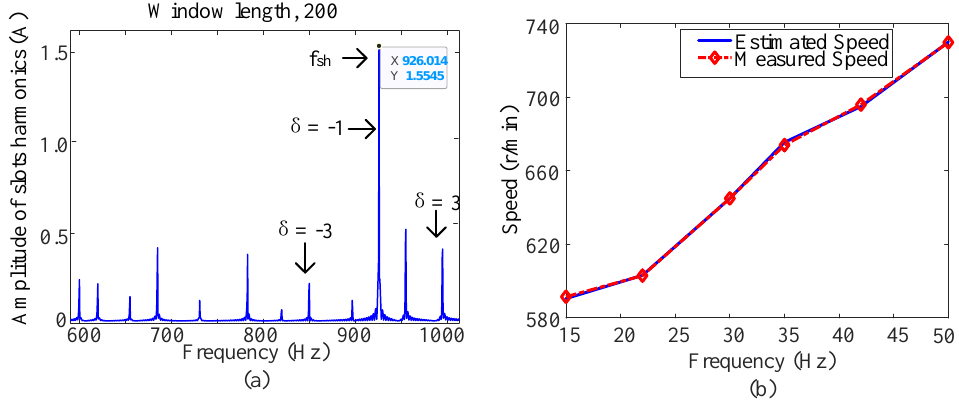
Figure 10. ( a ) Extracted slot harmonic frequency f sh = 926 Hz, speed n = 730 r/min, ( b ) estimated and measured speeds under different frequency conditions with constant torque.